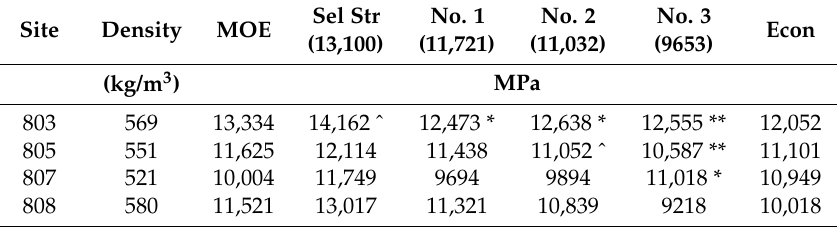
Table 4. Average density (weighted by lumber volume) and lumber MOE by site and visual grade (number in parentheses is MOE design value of the grade).